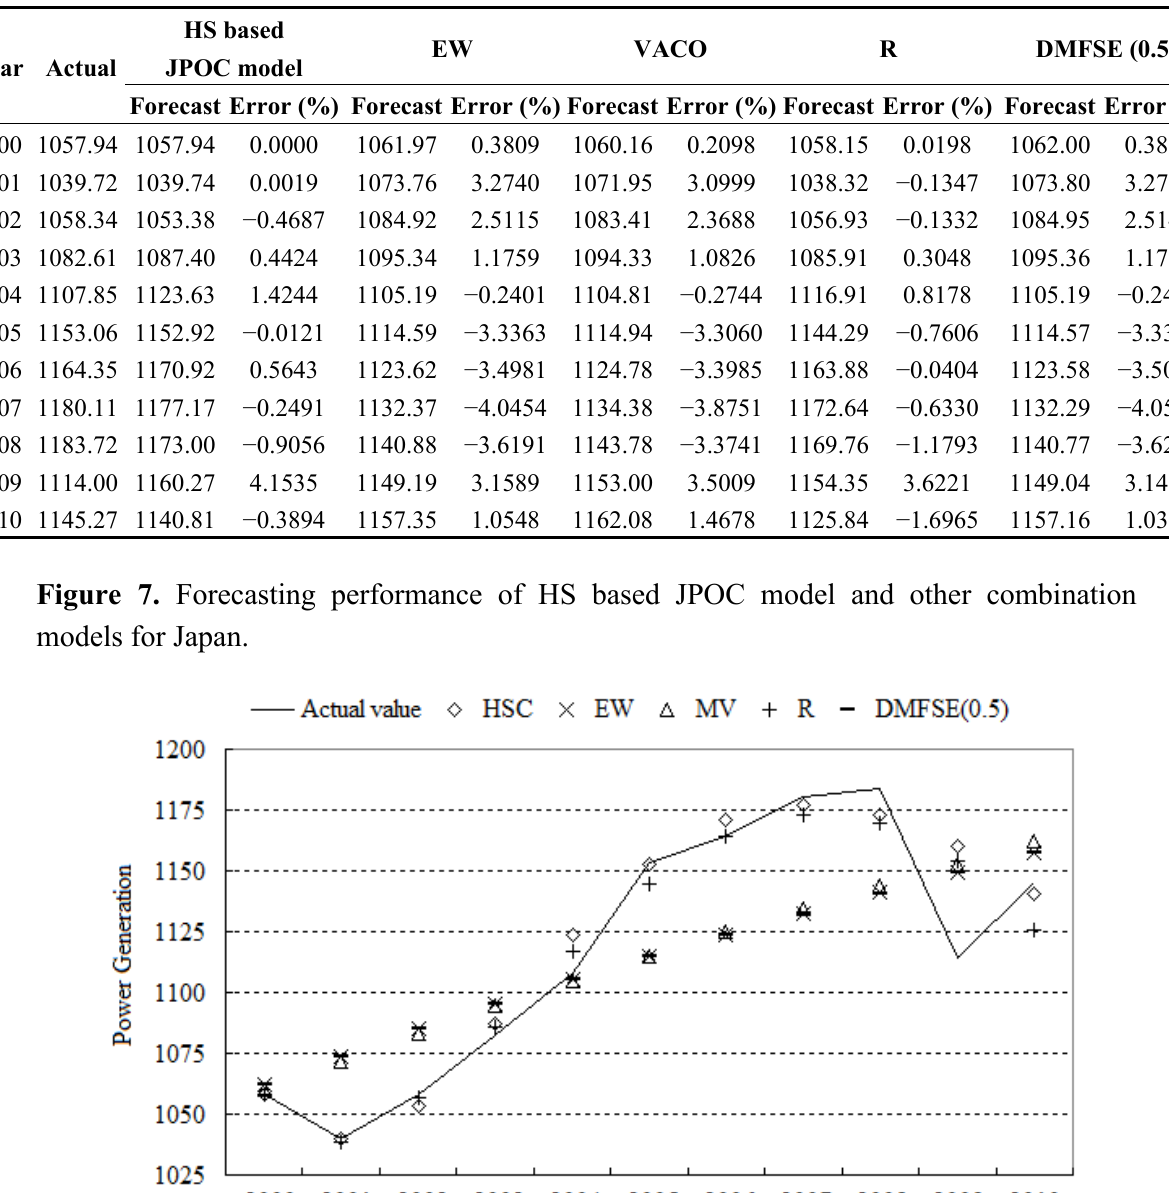
Table 9. Forecasting results of HS-based JPOC model and the other combination models for Japan (TWh).